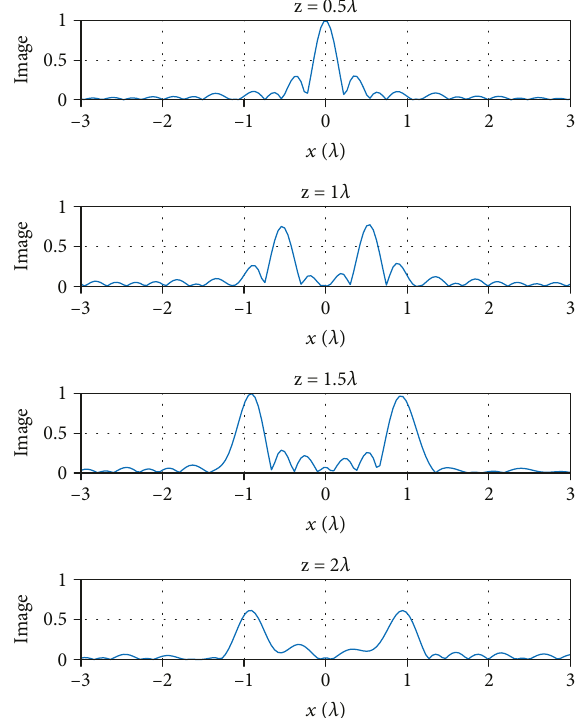
Figure 10: Reconstructed images when using 13 resonant dipole antennas. For this example, the parameters are z =0.5 λ , z = λ , 1 2 z =1.5 λ , z =2 λ , d = λ , d =2 λ , d =2 λ , s = λ /8, and D =0.25 λ . At 3 4 2 3 4 each sampling step, the 1st, 4th, and 7th antenna elements are excited sequentially and, for each cases, backscattered data is recorded by all antennas. These results are with SNR=20 dB.